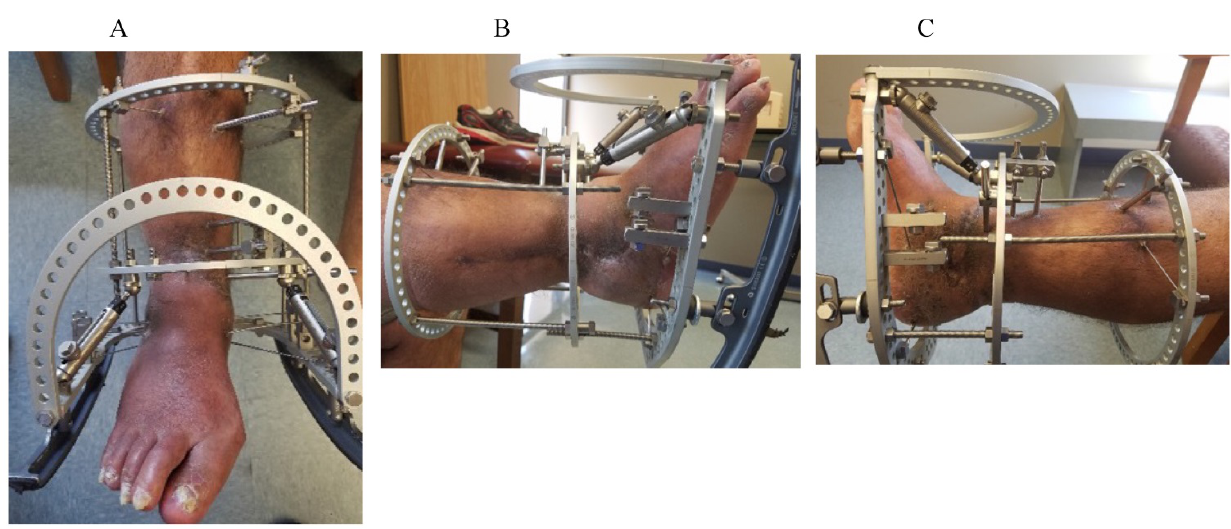
Figure 4: Right lower extremity (A-C) following successful infection eradication and tibiotalar fusion demonstrating healing of prior surgical sites and sinus